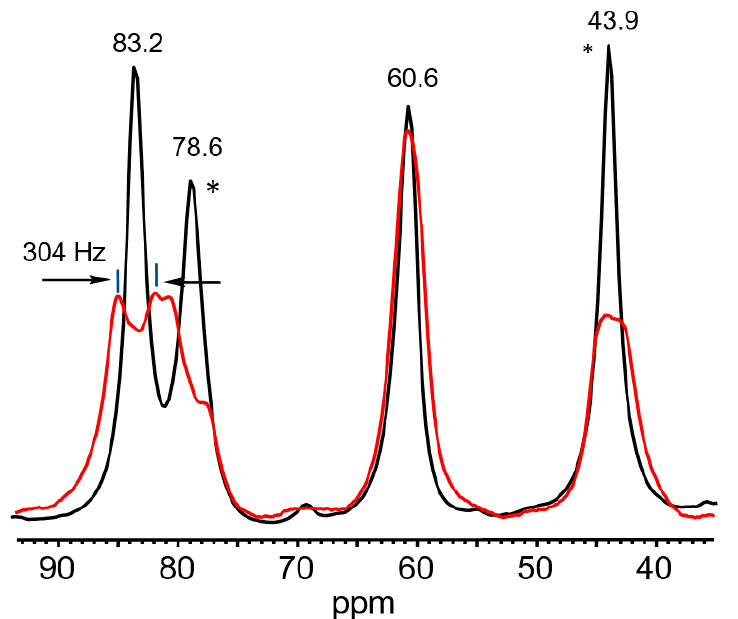
Figure 2. The 13 C MAS NMR spectrum of the isotope ‐ substituted 13 C ‐ (C 2 H 3 ) 2 Cl + {Cl 11 − } salt (99% 13 C) (99% 13 C) with (black) and without (red) high-power 1 H decoupling. Signals of the one vinyl with (black) and without (red) high ‐ power 1 H decoupling. Signals of the one vinyl group differing from another are marked with asterisks. group differing from another are marked with